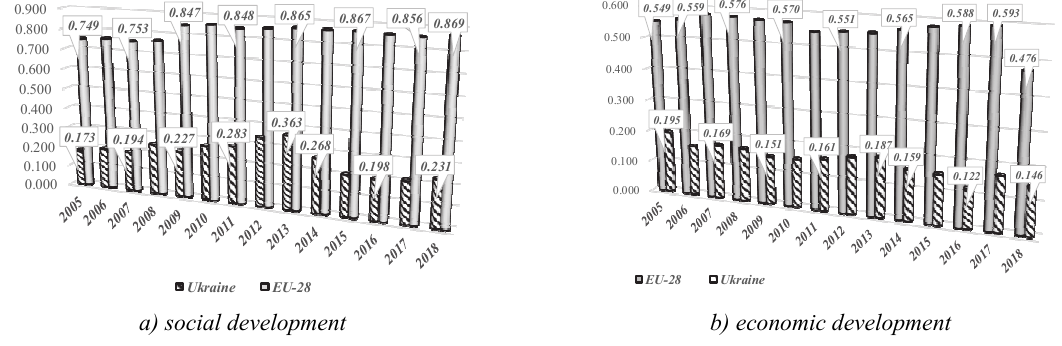
Fig. 3. Social and economic development indices in Ukraine and the EU-28,